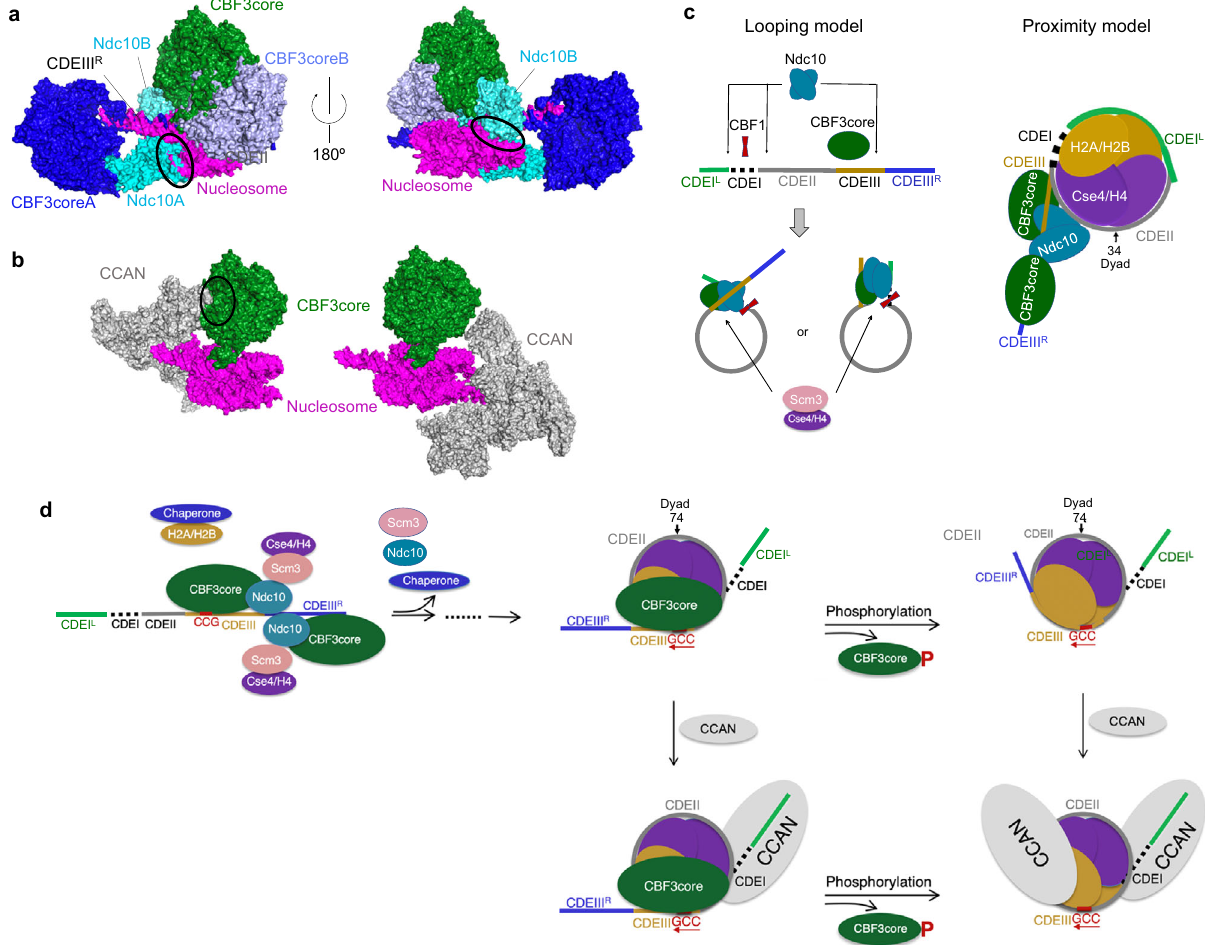
Fig. 4 Proposed mechanism of CBF3-guided formation of the CENP-A Cse4 CEN3 nucleosome and its association with CCAN. a Overlay of the structures of the CBF3core – nucleosome and (CBF3) 2 -DNA (PDB ID: 6GYS) complexes through alignment of the CCGs region and Gal4 domains in the two structures. CBF3core binds to DNA and the nucleosome in different orientations and the two Ndc10 subunits (cyan) have steric clash with the nucleosome (magenta) as indicated by circles (black). b Overlay of the structures of CBF3core – nucleosome and CCAN – nucleosome complexes (PDB ID: 6Q1D) by aligning the nucleosome structures. CCAN bonding to the CDEIII R DNA (left) can cause steric clash with the CBF3core as indicated by the circle (black), whereas its binding to the CDEI DNA side can be accommodated by the binding of CBF3core (right). c Diagram illustration of “ looping ” (left) and “ proximity ” (right) models. The dyad in the proximity model is at nucleotide sequence number 34 (Fig. 1a). d Diagram illustration of the speculated structural and dynamic mechanism. After DNA replication, the CEN3 DNA is recognized by the CBF3 dimer. Ndc10 in the CBF3 associates with Scm3 bound to CENP-A Cse4 -H4. The chaperones of H2A – H2B and CENP-A Cse4 -H4 deliver the histones to form the CENP-A Cse4 nucleosome – CBF3core complex, which could involve various intermediate states (dashed line between the arrows). Note that the dissociated Ndc10 – Scm3 might still interact with the linker or nucleosomal DNA in a DNA sequence-independent manner. Also, CDEI could be available for binding of CBF1 in both the CBF3core – CEN3 nucleosome complex and free CEN3 nucleosome. The CBF3core – CEN3 nucleosome complex can only recruit one copy of CCAN on the CDEI side. The free CEN3 nucleosome can recruit two copies of